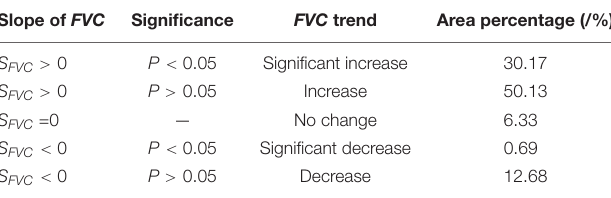
TABLE 3 | Statistical analysis results of FVC trends in treeline transition zone.